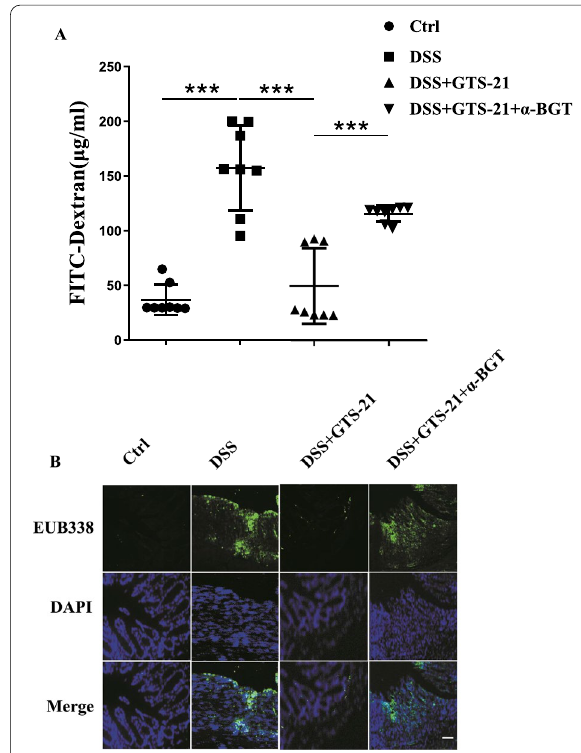
Fig. 2 GTS-21 attenuates intestinal permeability and reduces intestinal bacterial translocation in DSS-induced colitis mice. A The gut mucosal permeability was evaluated by measuring the leakage of fluorescein isothiocyanate (FITC)–dextran from the intestinal pouch. *** p < 0.001. B Bacteria penetrating in DSS-induced colitis was determined by fluorescence in-situ hybridization (FISH) of EUB338 probe (green, EUB338 probe; blue, DAPI nuclear staining). Magnification, 400. Scale bar, 100 ×